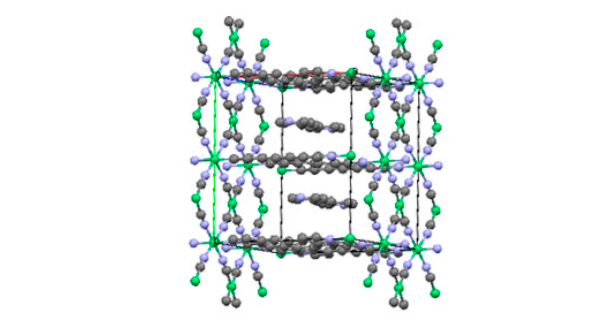
Figure 7. The 2-D tetracyanonickelate square grid network in Ni-Bpene (C-grey, N-blue,